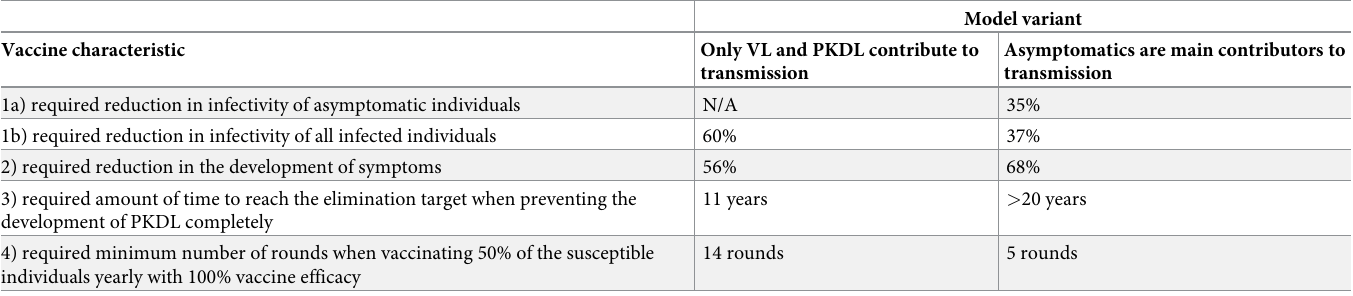
Table 2. Minimum required effect of the vaccine characteristics to reach a VL elimination target incidence of 1/10,000/year within 10 years’ time after starting the intervention, when vaccinating 100% of the population in a setting with a 5/10,000/year pre-control